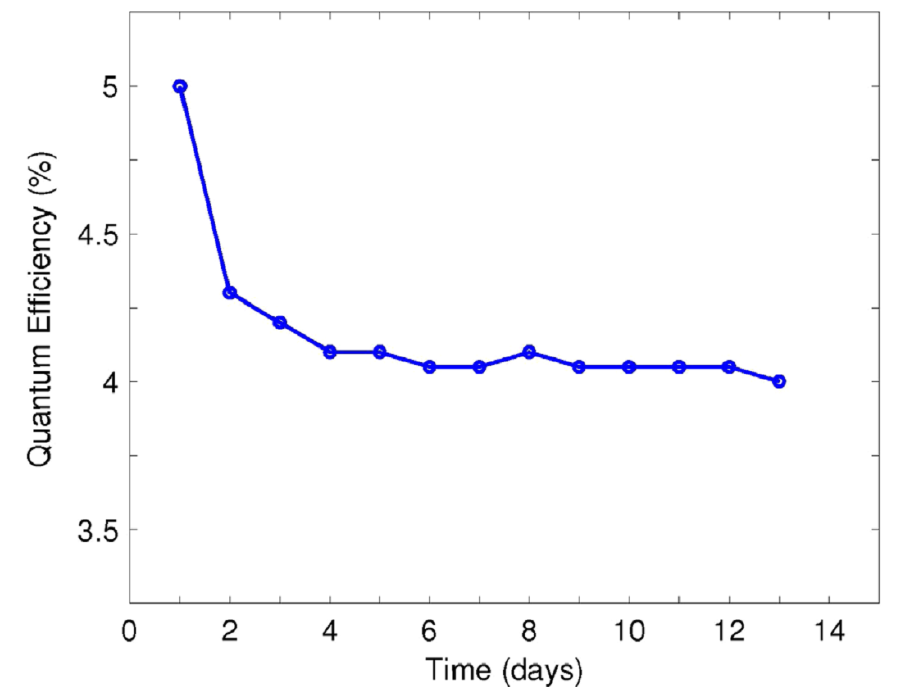
Figure 2. The QE of the Cs 2 Te photocathode in the PKU DC-SRF-I photoinjector [48]. Reproduced with the permission from reference